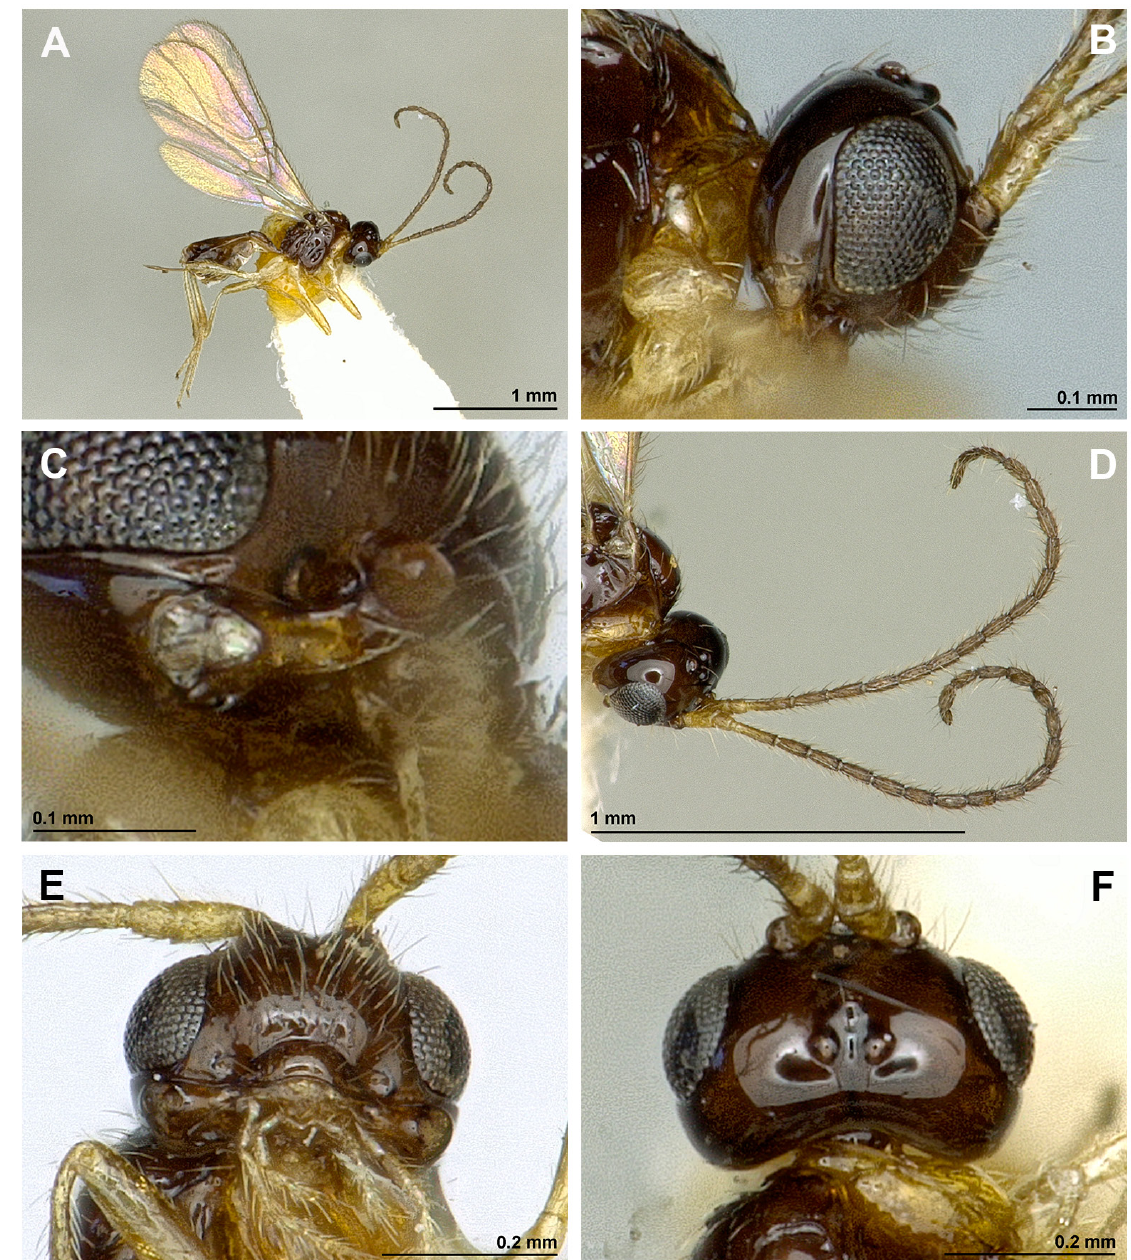
Fig. 2. Synaldis brasiliense Peris-Felipo, sp. nov., ♀. A . Habitus, lateral view. B . Head, lateral view. C . Mandible. D . Antenna. E . Face, front view. F . Head,